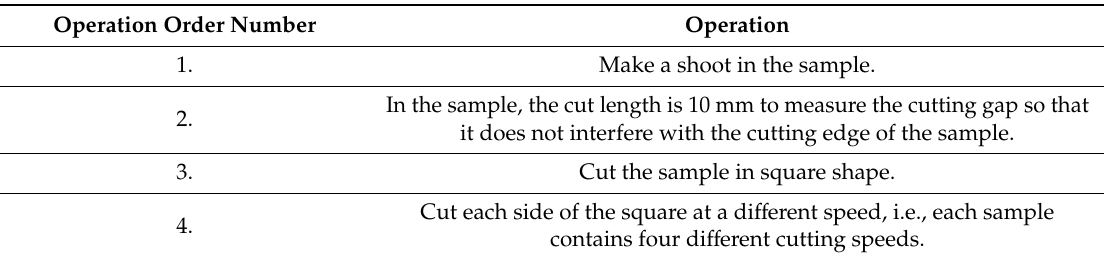
Table 3. The logistic sequence of cutting the test sample.